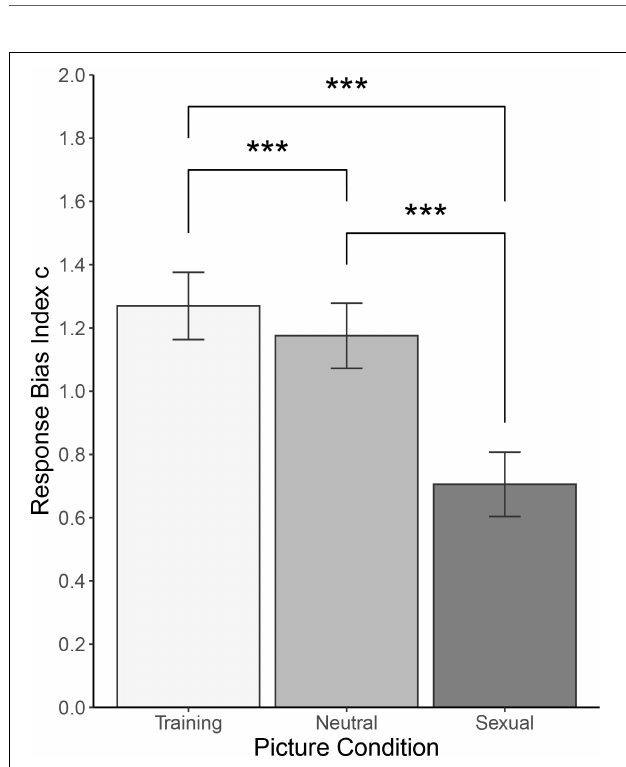
FIGURE 5 | Picture recognition task: Response bias c for training, neutral, and sexual pictures. *** p < 0.001. (once in each block), while training pictures were presented only once, one could expect better recognition memory for neutral pictures. Our results showed that neutral pictures were successfully recognized at just below 20% rate and training pictures at 15% rate, which lends further support to the dot-probe paradigm working as intended.